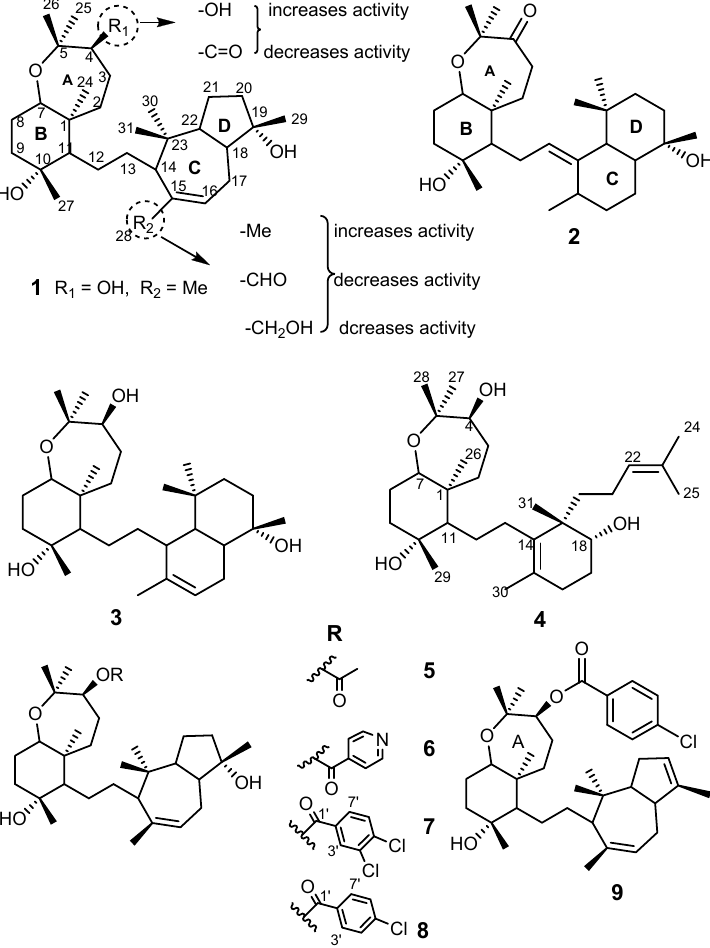
Figure 1. Structures of sipholane triterpenes 1 – 4 and their analogs 5 – 9 . Dashed circles indicate SAR studies performed for MDR activities.